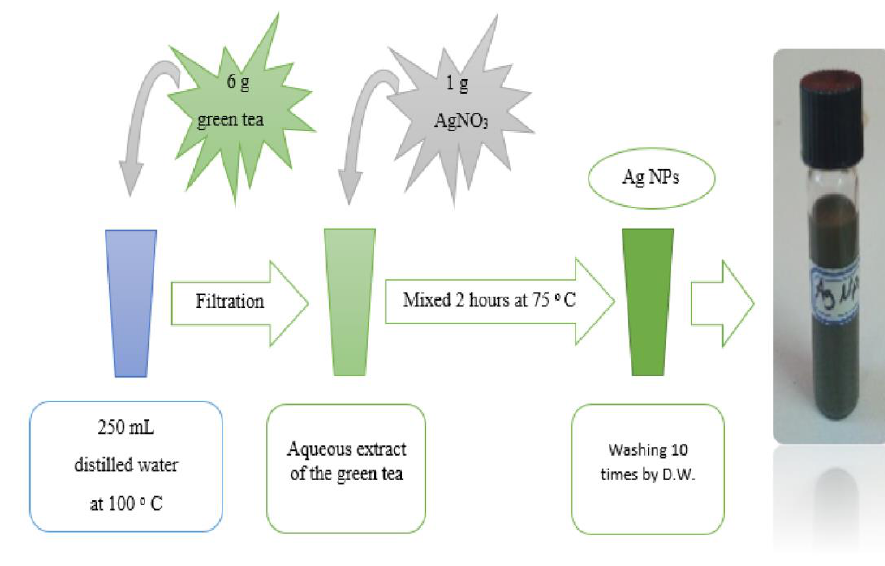
Figure 2. Schematic presentation of the Ag NPs